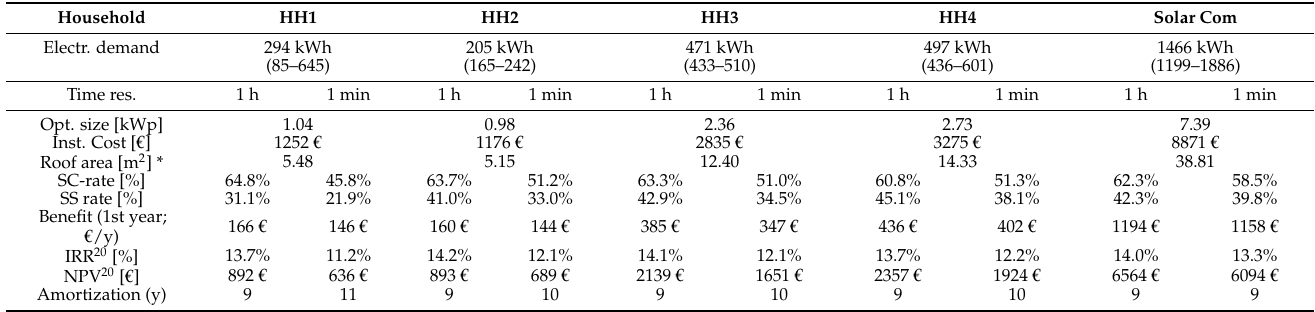
Table 4. Optimum size, installation costs and economic return estimated for the households (HH1– HH4) and the solar community (Solar Comm) under consideration of different time resolutions (minute and hour). SC-rate = self-consumption rate; SS-rate = self-sufficiency rate; IRR 20 = internal rate of return, 20 y perspective; NPV 20 = net present value, 20 y perspective. The table further highlights the value and benefits of community solar. * The required roof area for the estimated size of the PV installation without